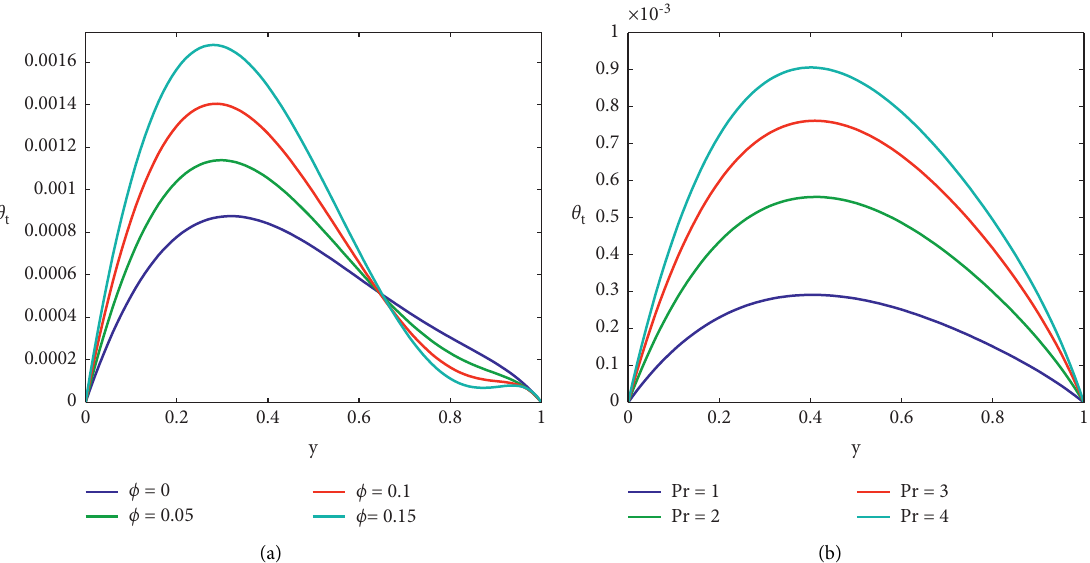
Figure 10: (a) Effect of φ on “unsteady temperature distribution” when Pr � 14. (b) Effect of Pr on “unsteady temperature distribution” for φ � 0 . 1.